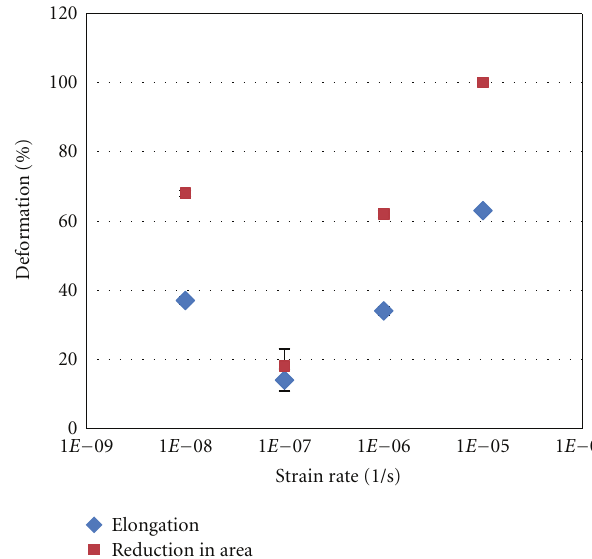
Figure 16: The embrittling factor index as a function of the strain rate of the slow strain-rate test at 45 ◦ C and 800 kPa.